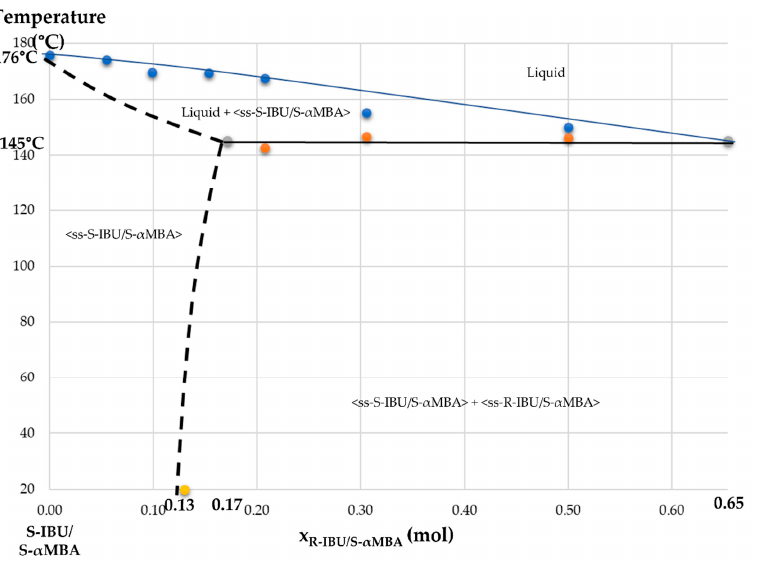
Figure 5. Revised binary system between S-IBU/S- α MBA and R-IBU/S- α MBA; focus on the part close to S-IBU/S- α MBA, the pure, less soluble salt. Binary phase diagram obtained with DSC measurements in sealed pans from 20 °C to 130 °C at a heating rate of 2 K/min. After 2 hours at 130 °C, every sample was cooled down to 20 °C (5 K/min) and then heated up to 200 °C (2 K/min). Blue curve = liquidus; black line = eutectic; dotted lines = limits of the partial solid solution. The solvus has been extrapolated with the following points: (T = 145 °C; X R-IBU/S- α MBA = 0.17) and (T = 20 °C; X R-IBU/S- α MBA = 0.13). NB: the authors assume that there is also a partial solid solution close to R-IBU/S- α MBA, which is why the second component of the biphasic domain is labelled ss-R-IBU/S- α MBA.